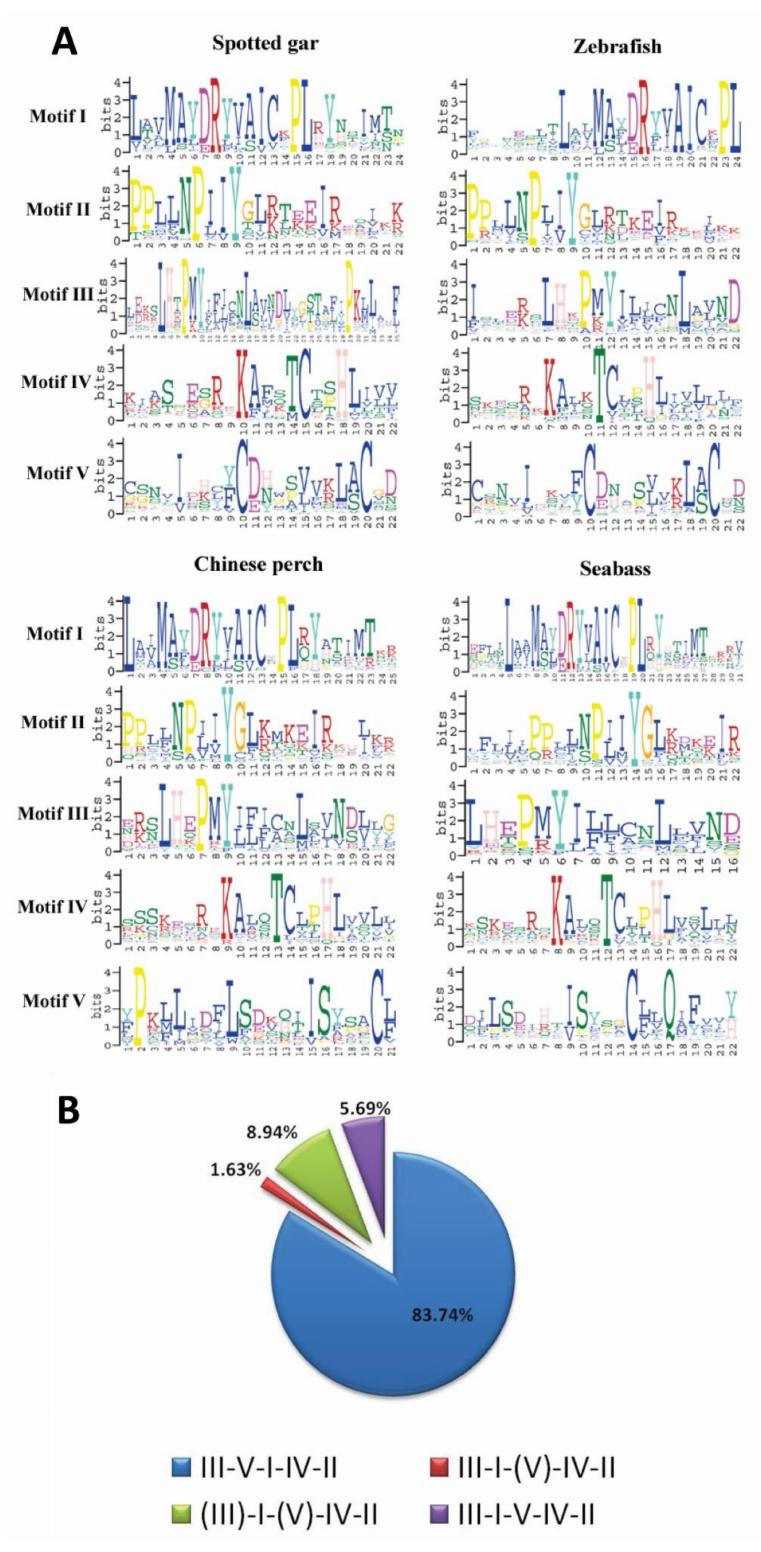
Figure 4. Logo representation of the five best conserved motifs identified for teleost OR genes, and the frequency of sequences with or without these motifs in Chinese perch. ( A ) Sequence logos of the conserved motifs, as the degree of conservation, was represented by the height of the amino acid code. ( B ) Proportional distribution of the total functional OR protein sequences, identified by their OR motif-containing patterns in Chinese perch. The motifs within parentheses were